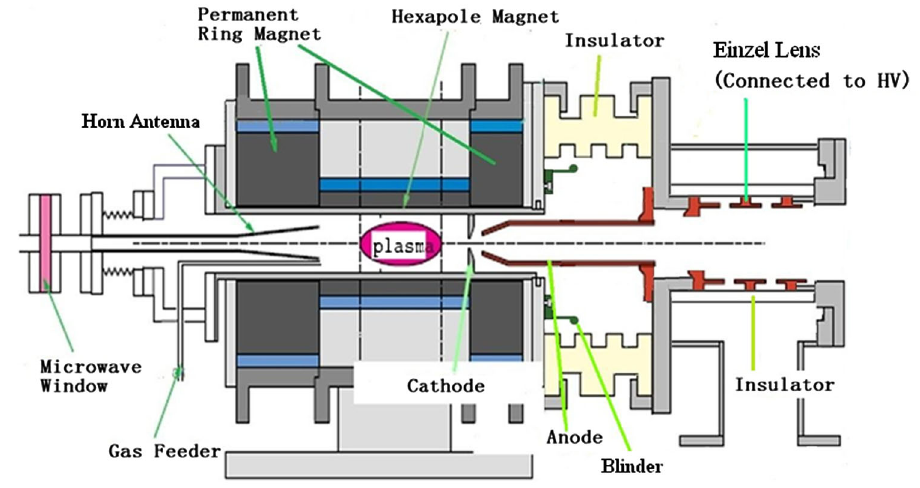
r ) at the minimum B r (